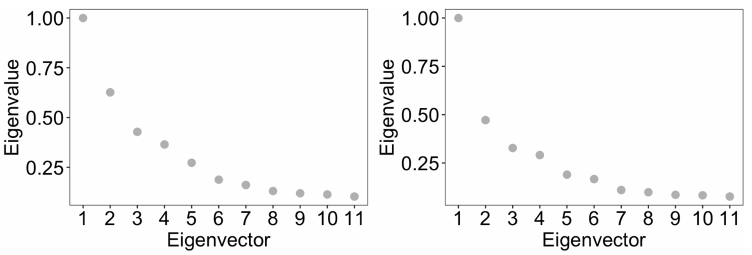
Figure A5. Comparison of BNB and BZINB correlations between all pairs of microbial species in ZOE 2.0 with respect to the total number of zeros in each pair.